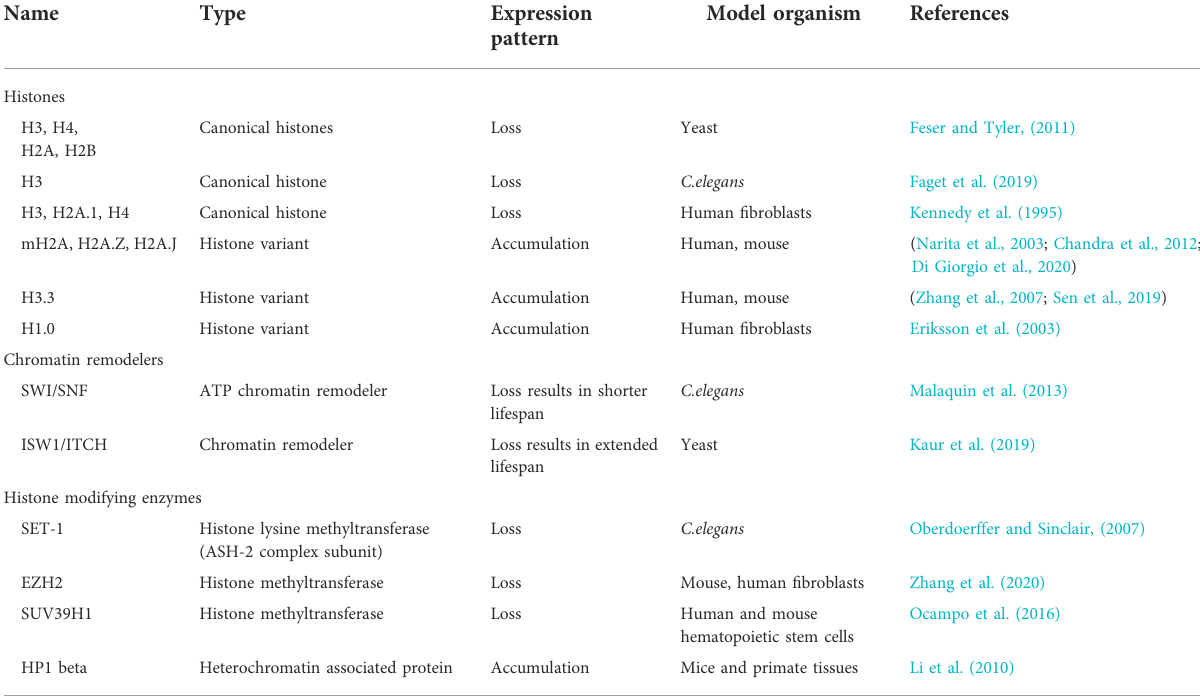
TABLE 1 Histones and Chromatin modi fi ers which are altered during